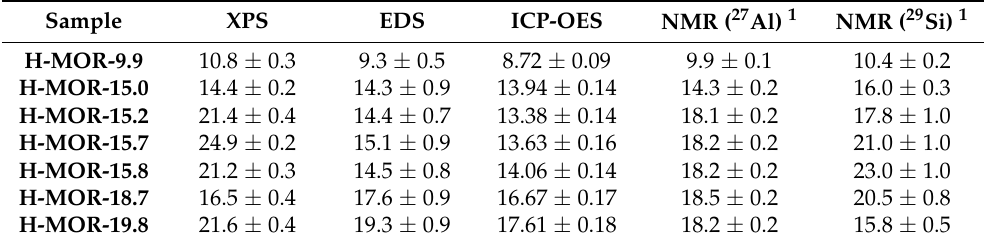
Table 1. SiO 2 /Al 2 O 3 ratio of the studied samples determined by different